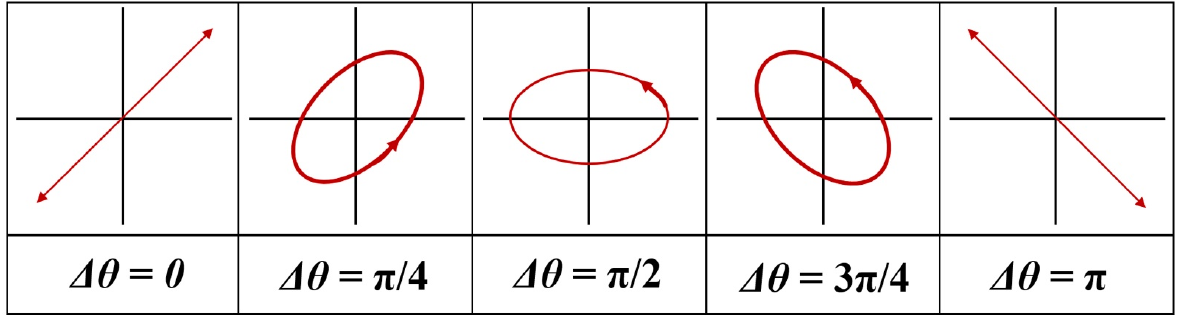
changes, as shown in Figure 6.